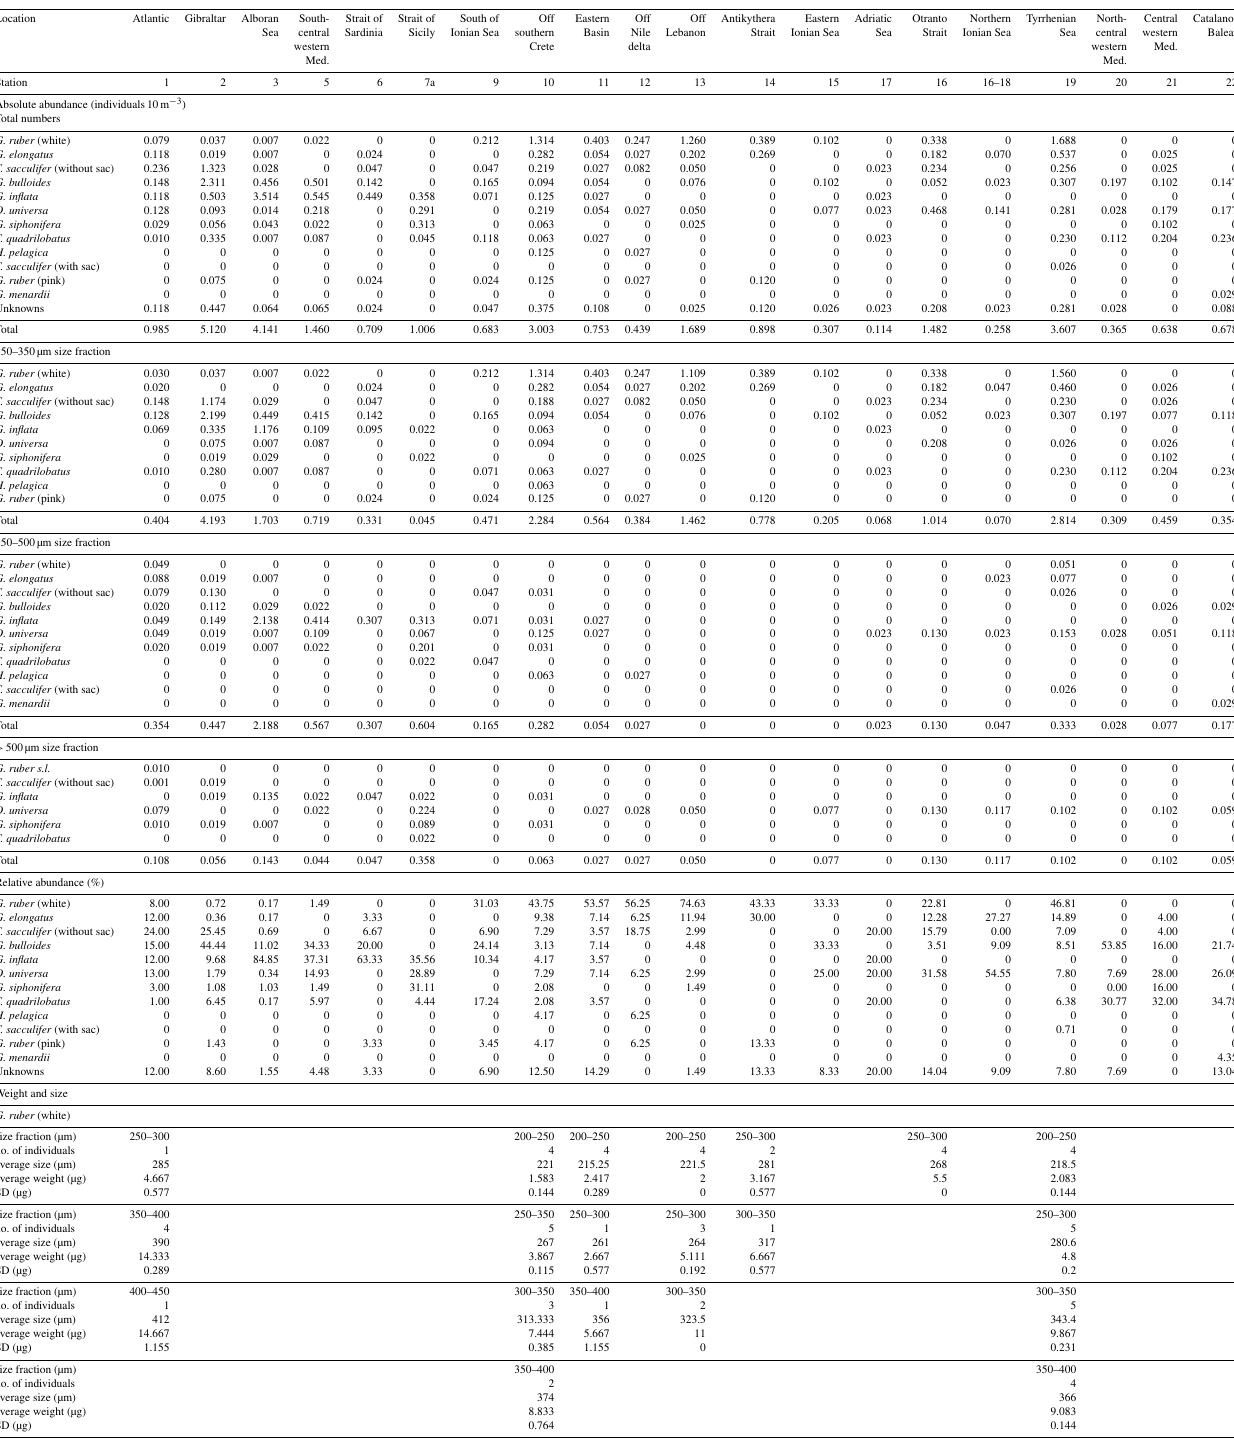
Table A1. Planktic foraminifera data from BONGO nets: relative and absolute abundances, and weight and size parameters. The nomencla- ture G. bulloides represents the G. bulloides–G. falconensis plexus, and G. siphonifera represents the G. siphonifera–G. calida–G. radians